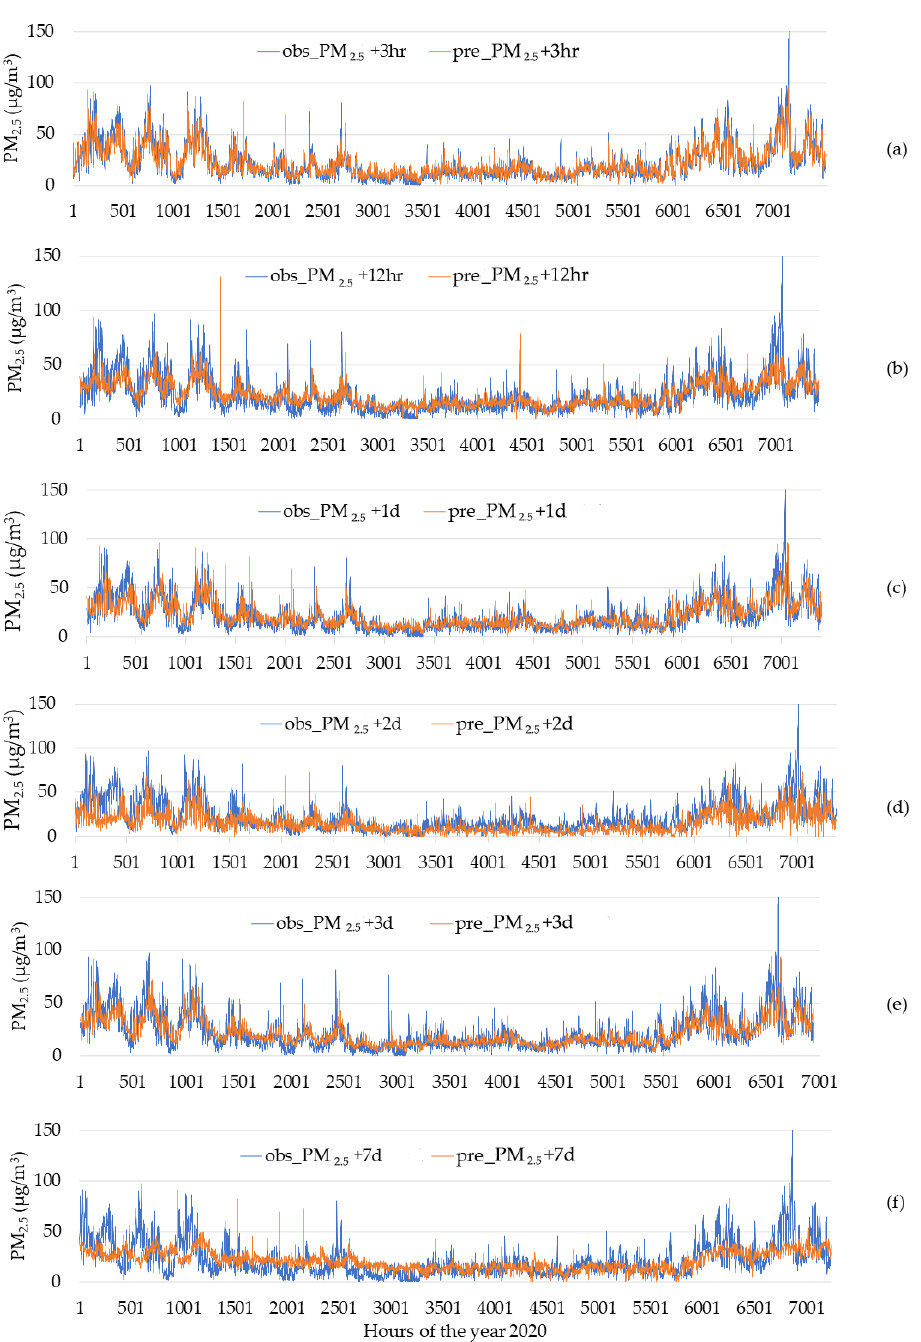
Figure 6. Measured and predicted PM 2.5 concentrations obtained using multiple linear regression modeling. Forward prediction for: ( a ) 3 h, ( b ) 12 h, ( c ) 1 day, ( d ) 2 days, ( e ) 2 days, ( f ) 7 days